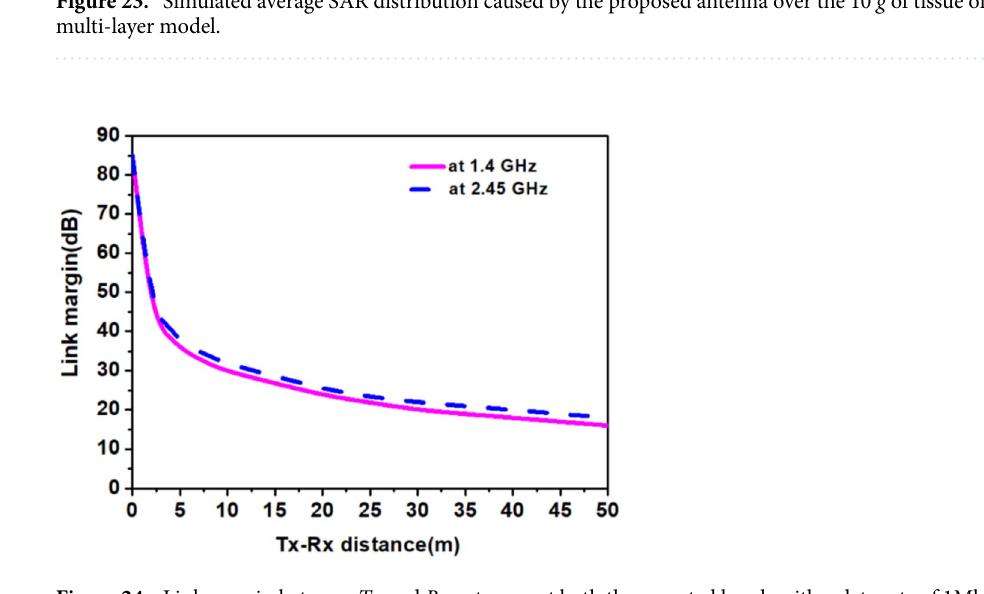
Figure 24. Link margin between Tx and Rx antennas at both the reported bands with a data rate of